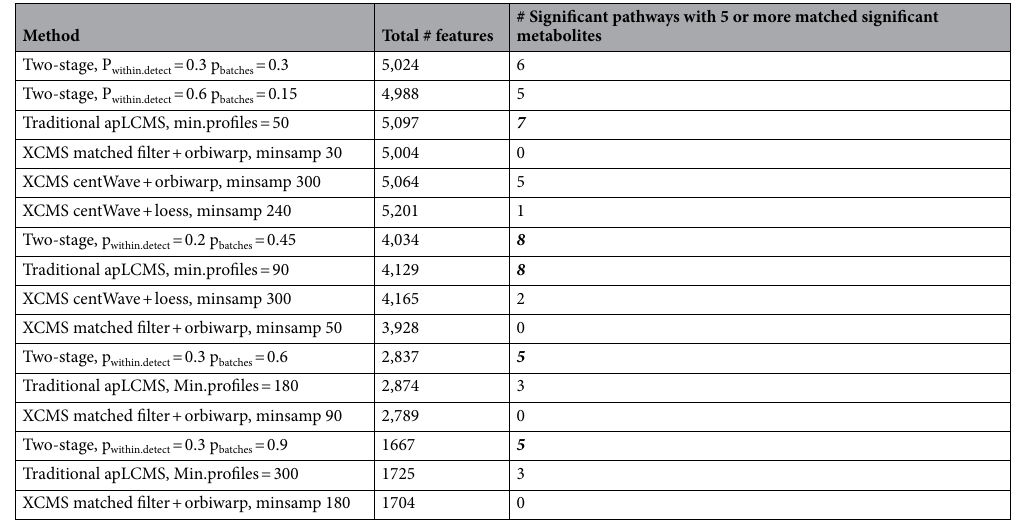
Table 1. Comparison of feature selection and pathway analysis results. BMI was used as the outcome variable. Age, age 2 , gender, and race were adjusted for in the model. Metabolic feature selection was conducted using features with < 25% zeros. Pathway analysis was conducted using Mummichog, using metabolic features with p < 0.05. The bold italic font represents the biggest number of significant pathways in the comparison group